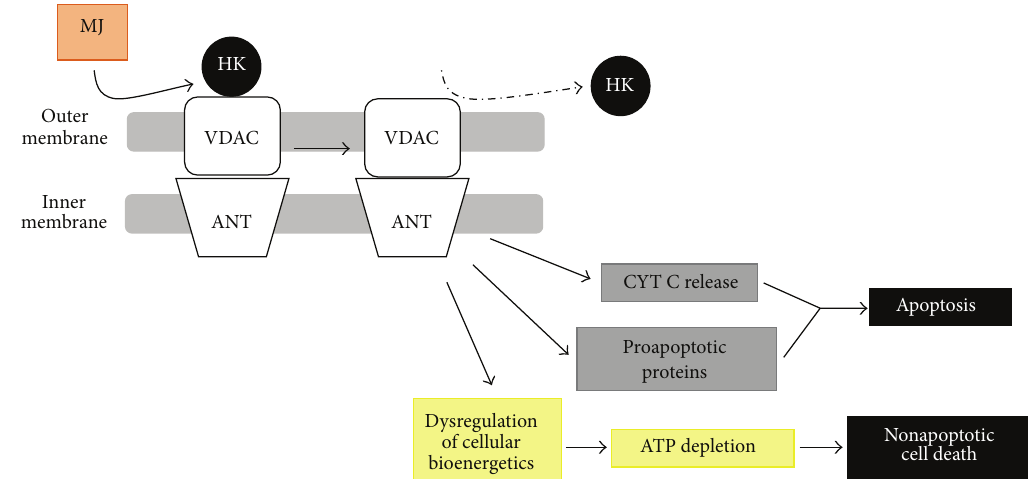
Figure 2: Effect of methyl jasmonate (MJ) on the mitochondrial bioenergetic metabolism of cancer cells. MJ dissociates HK2 from VDAC1 on the outer surface of mitochondria. As an immediate consequence, glycolysis dissociates from oxidative phosphorylation (OXPHOS) and a series of rapid events that occur, such the PTPC opening, mitochondrial membrane permeability deregulation and swelling, decrease of Δ𝜓 𝑚 and OXPHOS, ATP depletion, cytochrome 𝑐 release, induction of proapoptotic proteins, and cell death through apoptotic and nonapoptotic pathways.